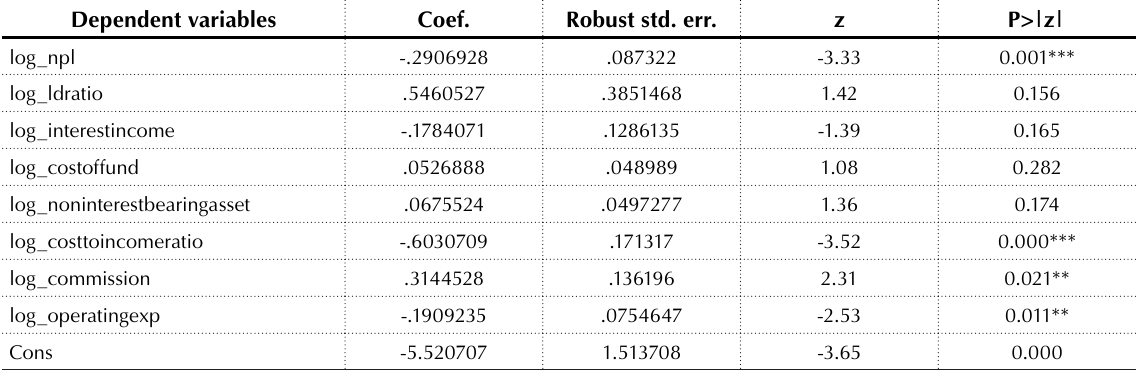
Table 3. Model 3 (Determinants of return on asset, robust estimation)